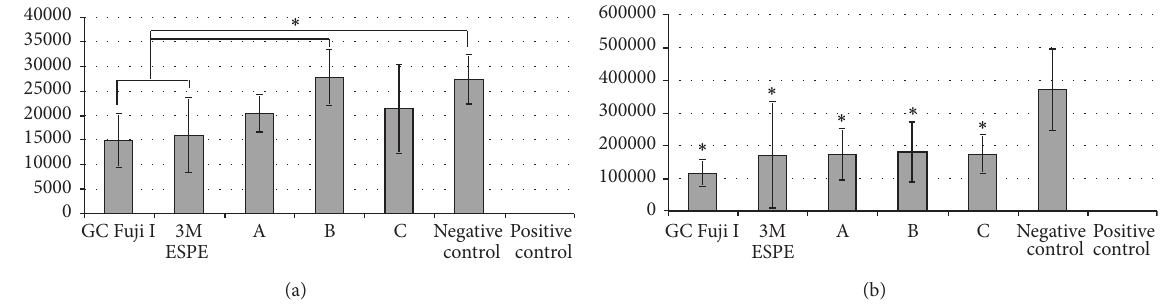
Figure 1: Bacterial count [CFU/mL] of adherent (a) and planktonic (b) bacteria after 4 h incubation of the different ionomer glass cement materials with log phase Streptococcus mutans . The 𝑦 -axis shows the CFU/mL.